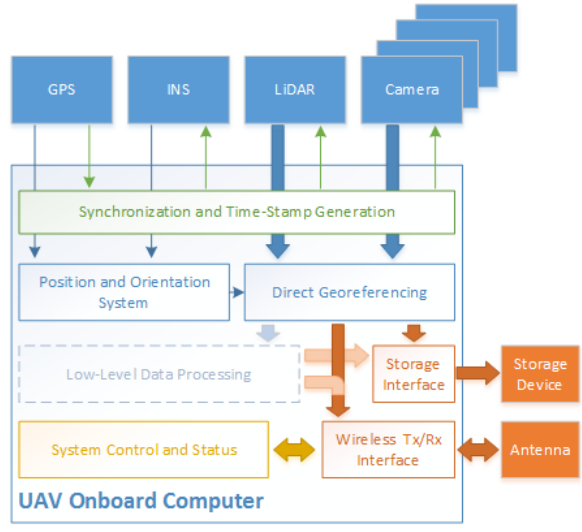
Figure 9: Payload system block digram